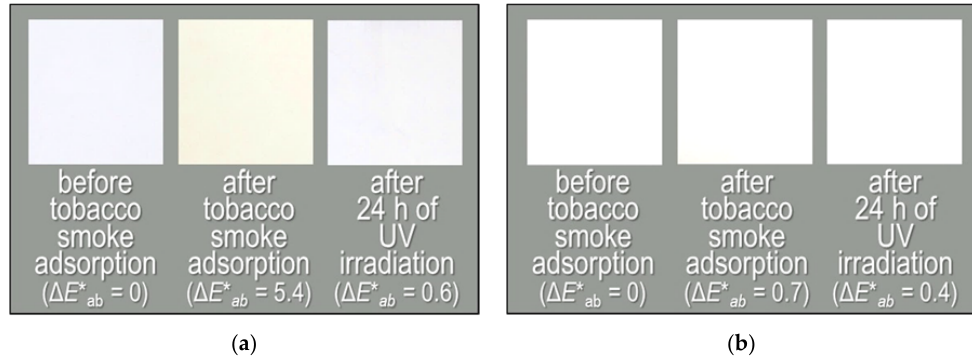
Figure 3. Photographs of the non ‐ woven fabrics before tobacco smoke adsorption, after tobacco smoke adsorption (0 h), and after 24 h of UV irradiation. ( a ) Non ‐ woven fabric with TiO 2 ; ( b ) non ‐ woven fabric without TiO 2 .